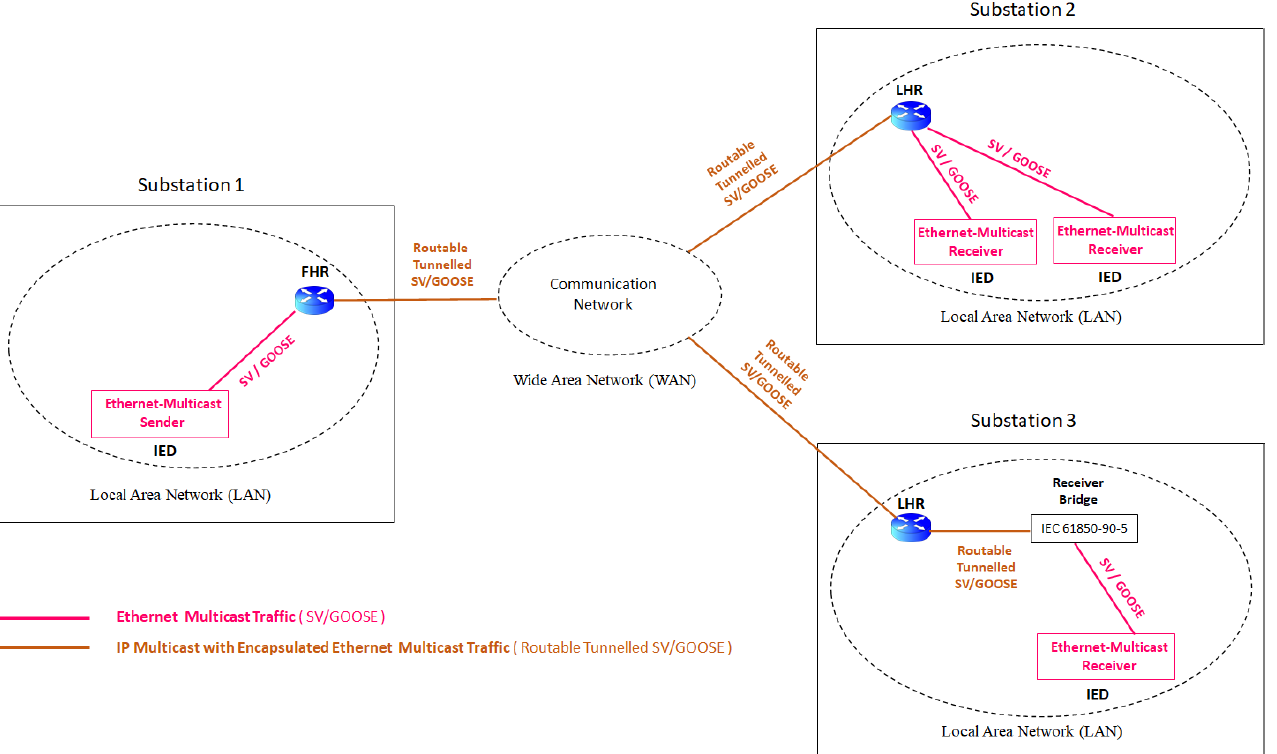
Figure 3. Multicast communication of Routable-Tunneled SV/GOOSE from Substation 1 to Substa- tion 2 and 3.